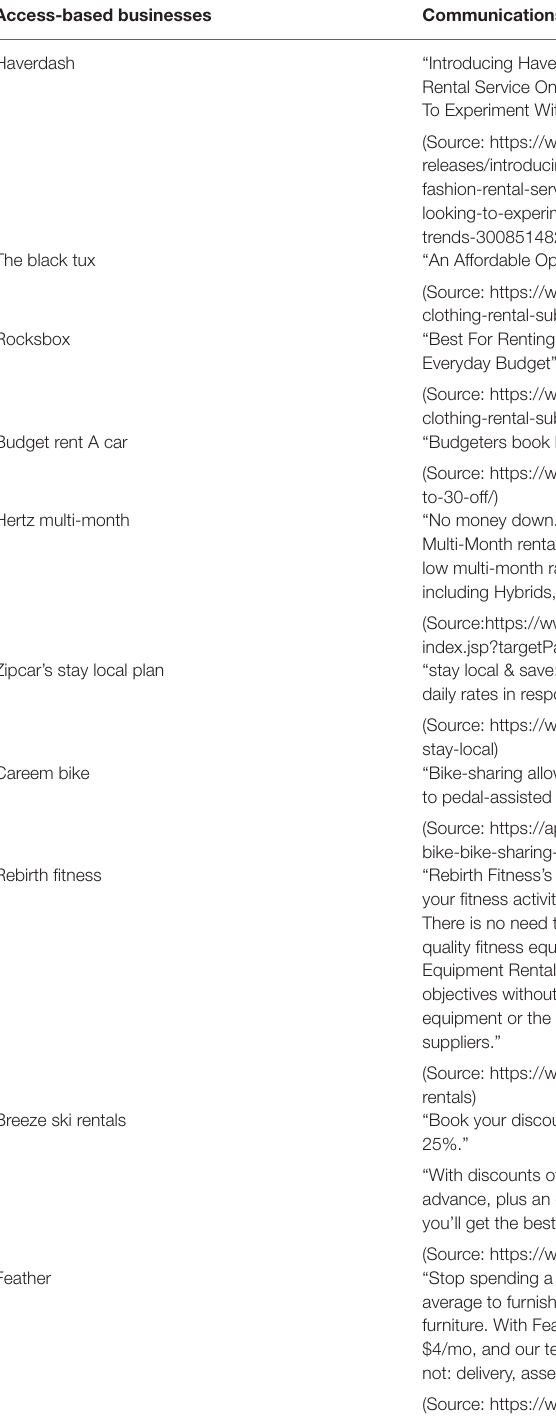
TABLE 1 | Affordability-based communications in the context of access-based